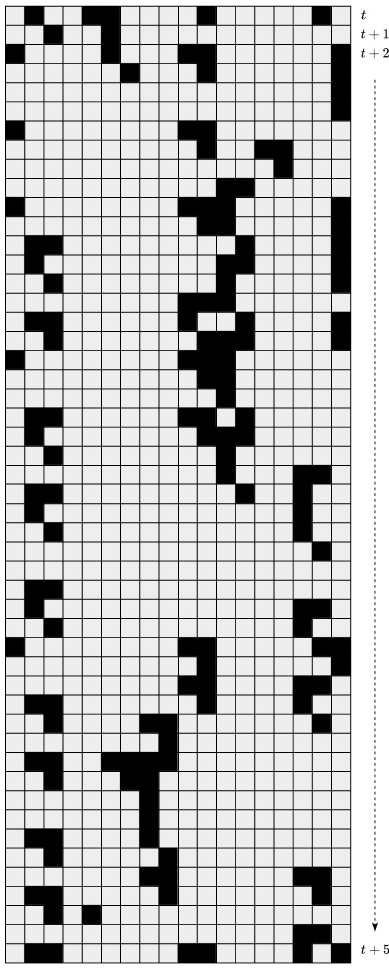
Figure 32. The resulting cellular sequence.